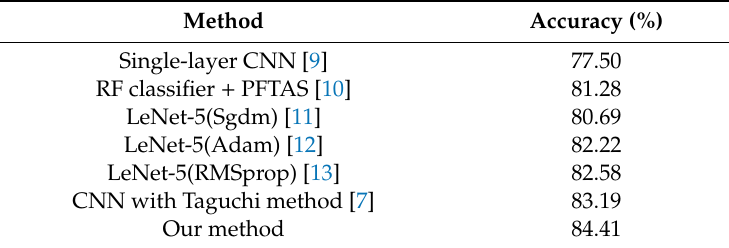
Table 9. Comparison results of the various methods.